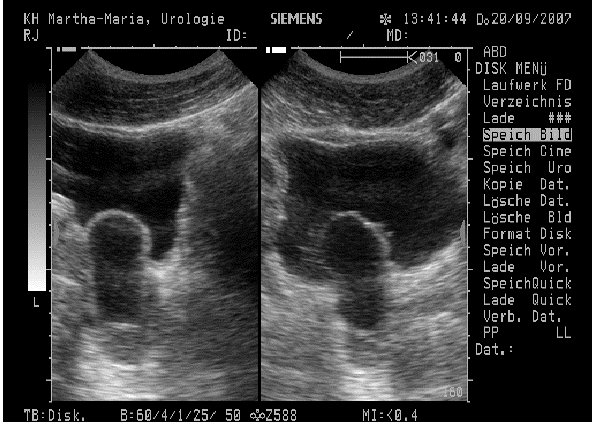
FIGURE 1. A solid hypoechoic, well-defined, and homogeneous mass projecting in the bladder.